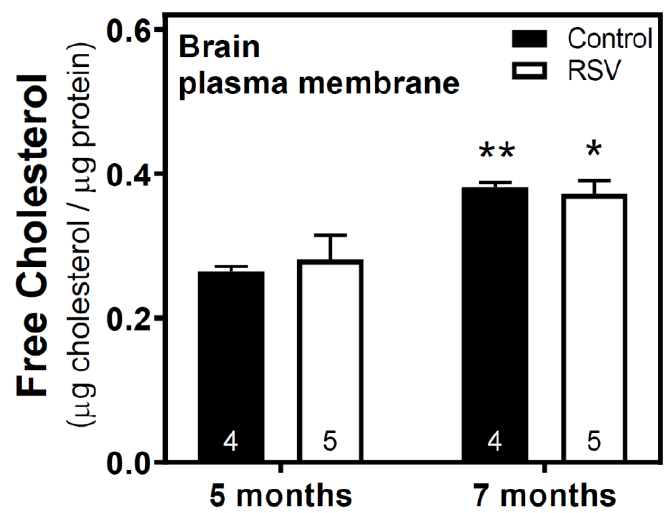
Figure 1. Levels of free cholesterol in the brain plasma membrane of SAMP8 mice. Free cholesterol was quantified in plasma membranes as described in the Methods section and the results were normalized to the amount of protein and represented as µg cholesterol/µg protein. Data are the mean ± SEM of the indicated different samples. Two-way ANOVA and a Sidak test for multiple comparisons were applied. * p < 0.05 and ** p < 0.01: significantly different from the corresponding 5 mo value.